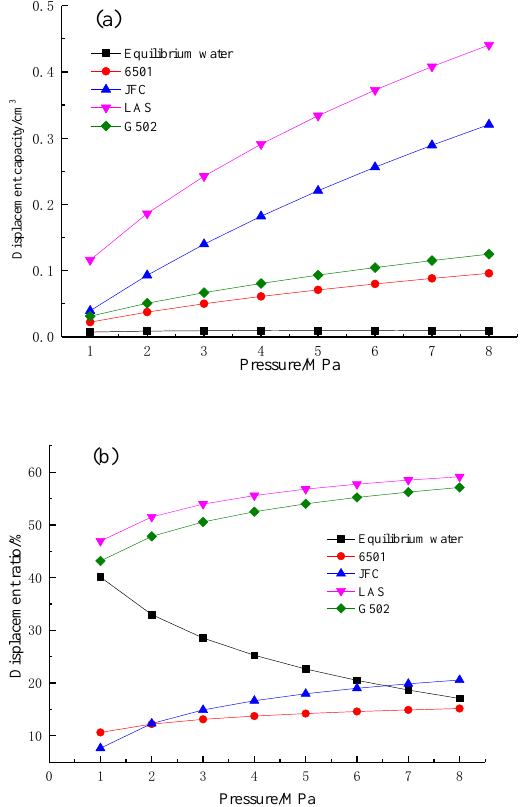
Figure 14. Methane displacement effect with different wettability: ( a ) displacement capacity; ( b ) ( b ) displacement displacement ratio.